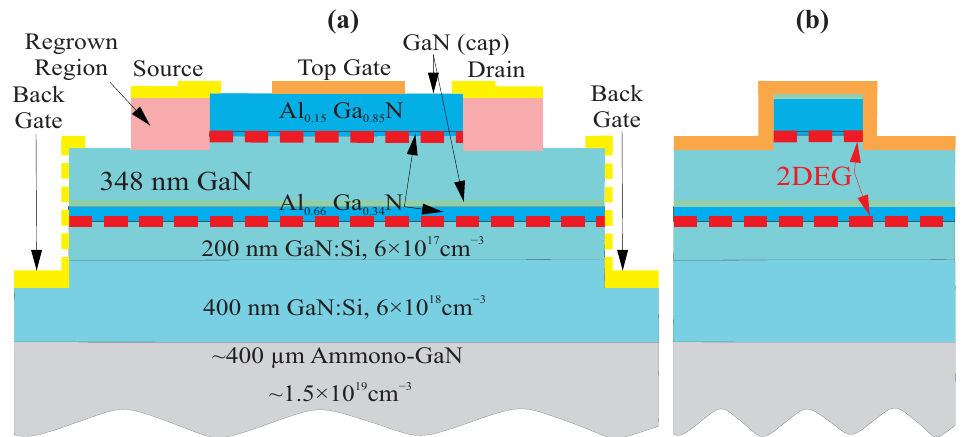
Figure 1. Cross -section views (not in scale) from source to drain ( a ) and perpendicular to it for fabricated AlGaN/GaN fin-shaped high electron mobility transistors (FinHEMTs) ( b ).